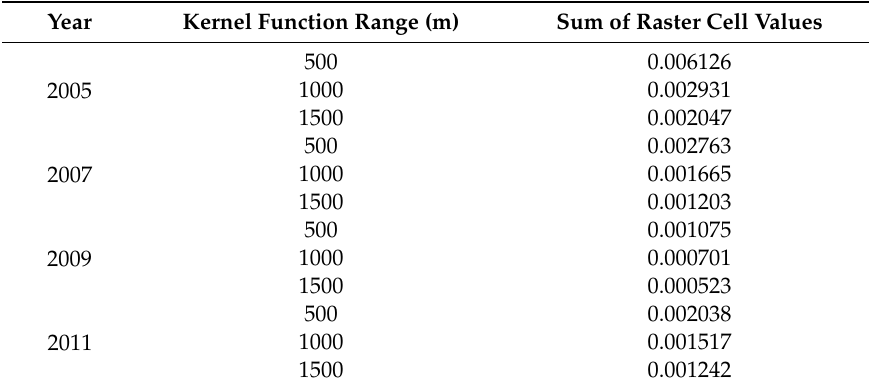
Table 2. Choice of the kernel function range in selected analysis